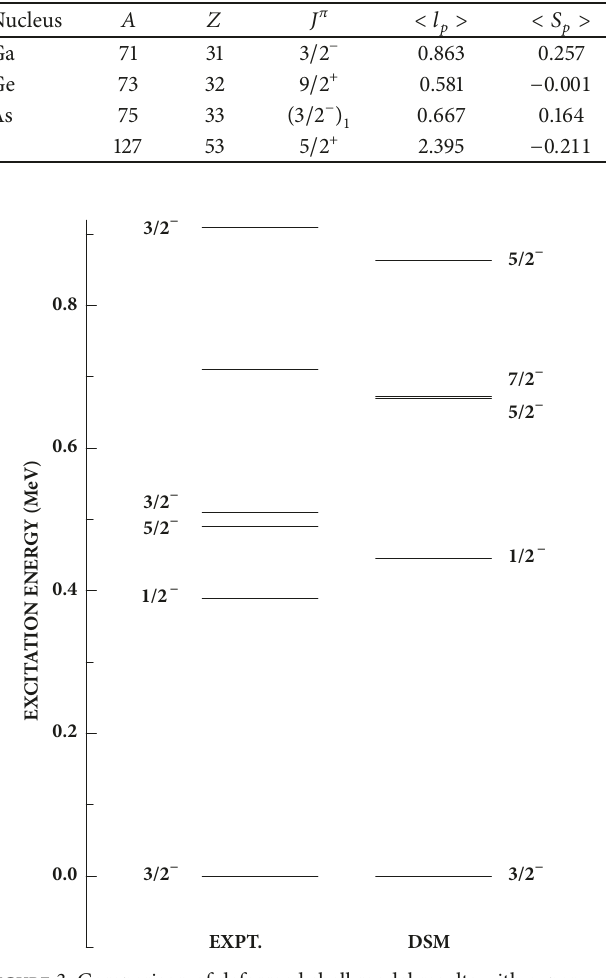
Figure 3: Comparison of deformed shell model results with exper- imental data for 71 Ga for low-lying states. The experimental values are taken from